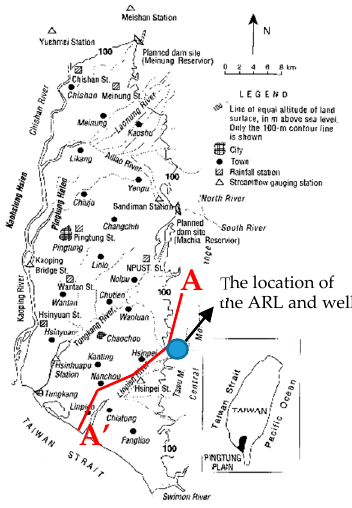
Figure 1. Location map of Pingtung Plain, after [22]. Table 1. Rainfall stations in the study catchment.